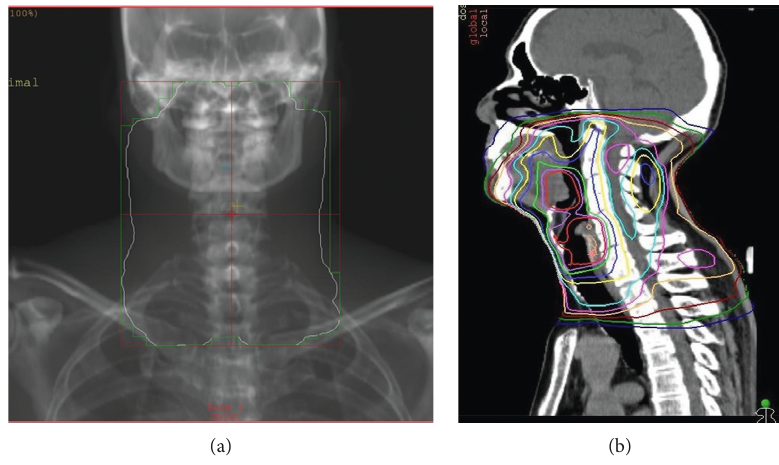
Figure 5: Distribution map of radiotherapy.